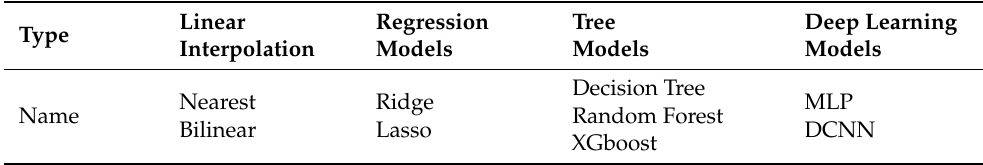
Table 1. Summary of models used in this